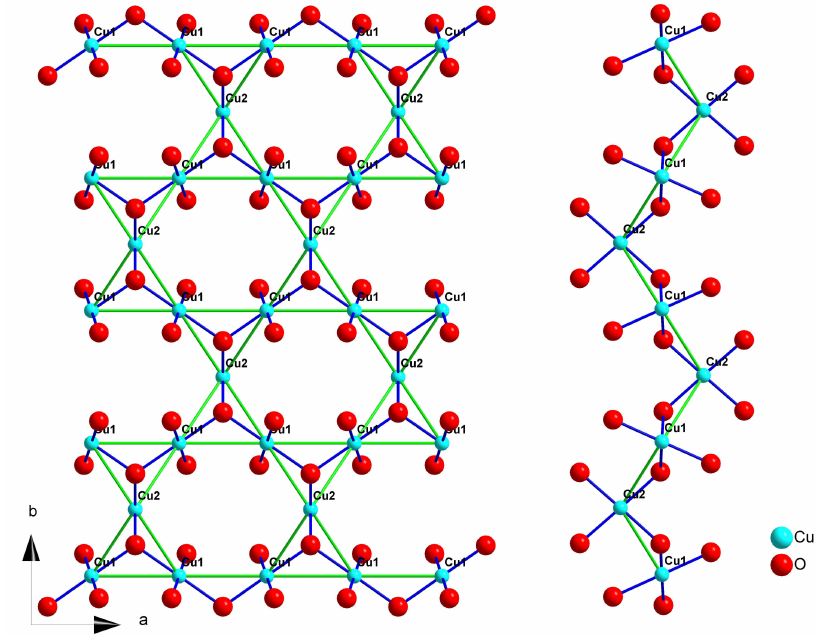
Figure 15. The copper-oxygen net in the crystal structure of Francisite-like compounds crystal structure shown in different direction. Cu–Cu contacts are marked as green. The right part of the figure shows the buckled nature of the kagome net.